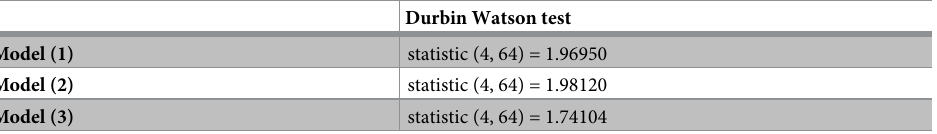
Table 11. Autocorrelation test: Durbin